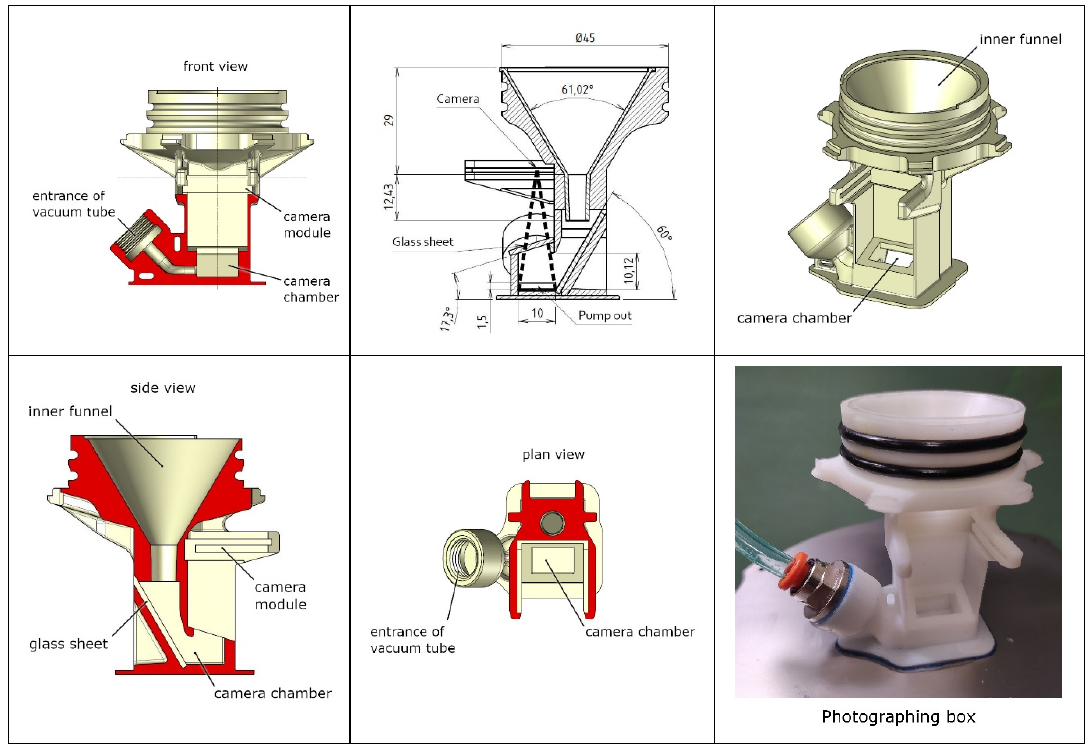
Figure 2. Blueprints of the photographing box (front and side views). Microarthropods fall into the inner funnel and enter the camera chamber. After the photo shooting, the specimen is pumped out from the camera chamber through a plastic pipe.